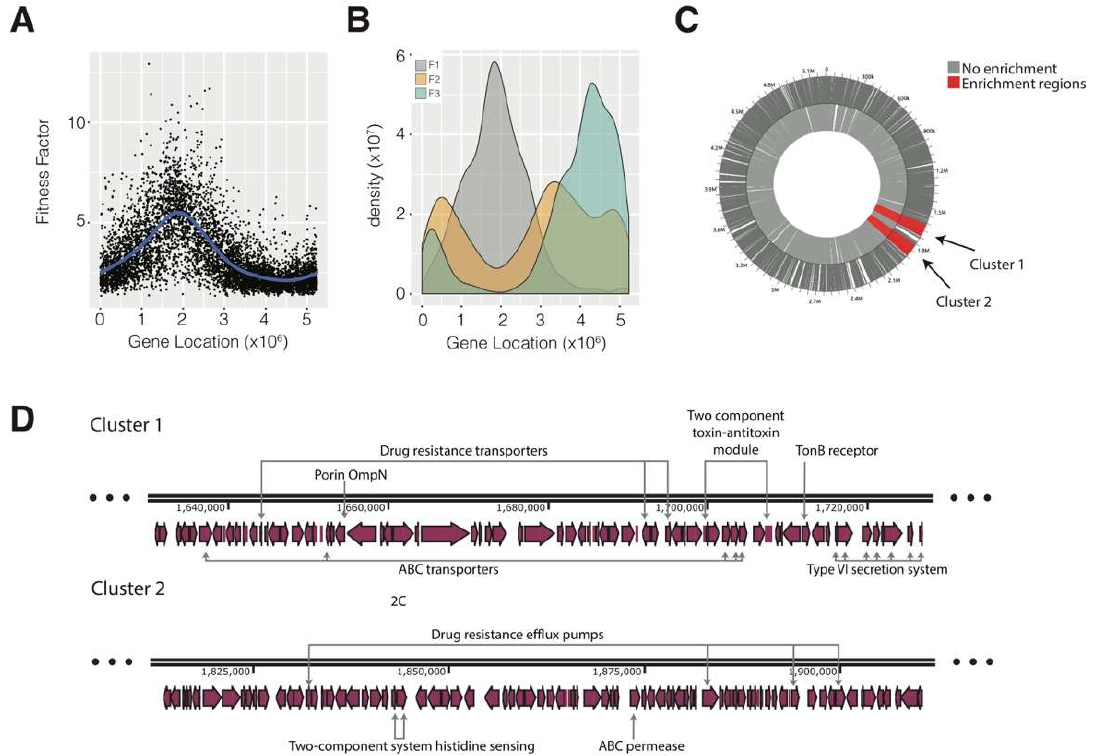
Figure 2. Gene localization analysis and fitness enrichment in the E. coli genome. ( A ) Distribution of fitness factors along the E. coli CFT073 genome ( B ) Genome localization of genes according to the fitness classification (F1 genes in grey, F2 genes in orange and F3 genes in green). ( C ) Positional enrichment analysis of fitness-related genes in the genome. According to WoPPER, two clusters of genes were identified. The functional enrichment of both clusters was weak due to a high number of uncharacterized and hypothetical proteins. ( D ) Detail of the two clusters identified by positional enrichment. Some proteins belonging to the F1 main functional categories were identified in both clusters and are highlighted as exemplars in the figure, e.g. two-component system and ABC transporters.